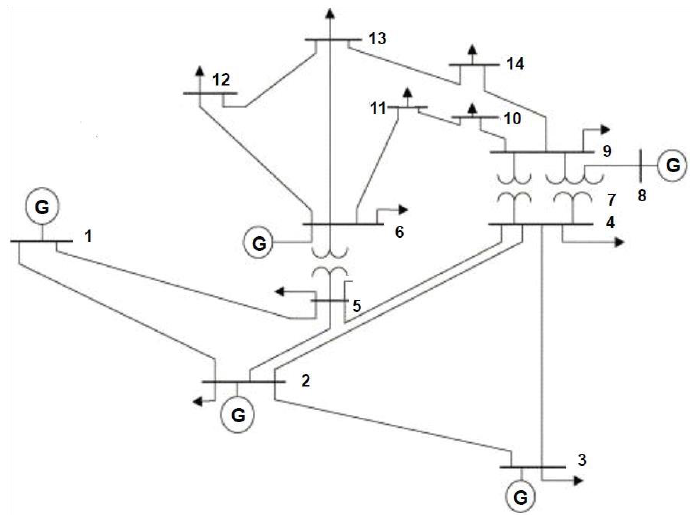
Figure 8. IEEE 14 BUS system single line diagram using TCSC.